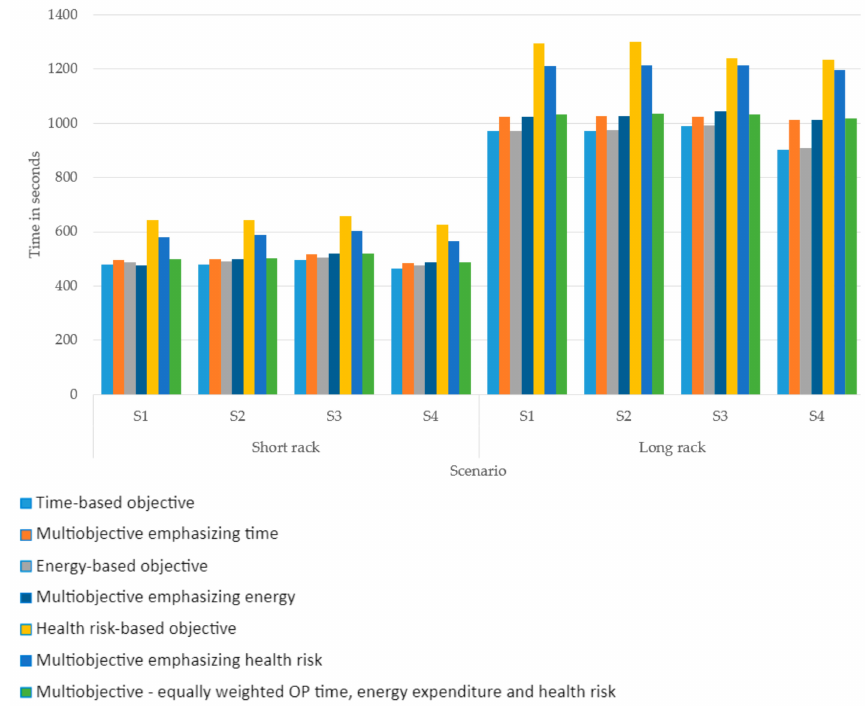
Figure 9. Comparisons of order picking times from different objective